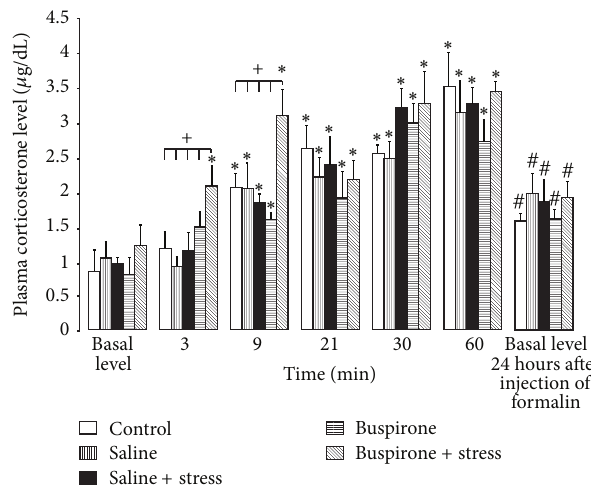
Figure 2: Basal levels of corticosterone and plasma corticosterone levels ( 𝜇 g/dl) determined 3, 9, 21, 30, and 60 min after injection of formalin (mean ± SEM) in 7-day-old male rats with different prenatal treatments. ∗ P < 0.05 different from the basal level; + P < 0.05 different from the control, saline, saline + stress, and buspirone; # P < 0.05 different from the basal level before injection of